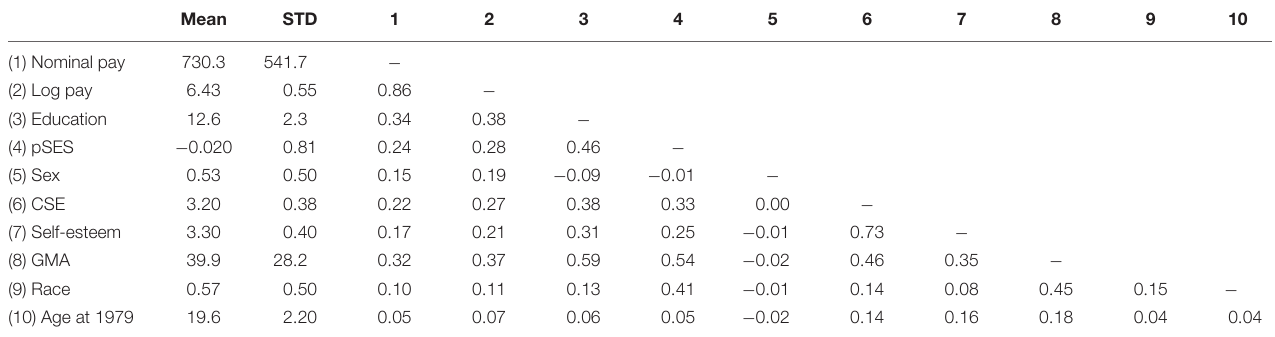
TABLE 3 | Descriptive statistics and inter-correlations of the variables in Studies 2 and 3. Mean STD 1